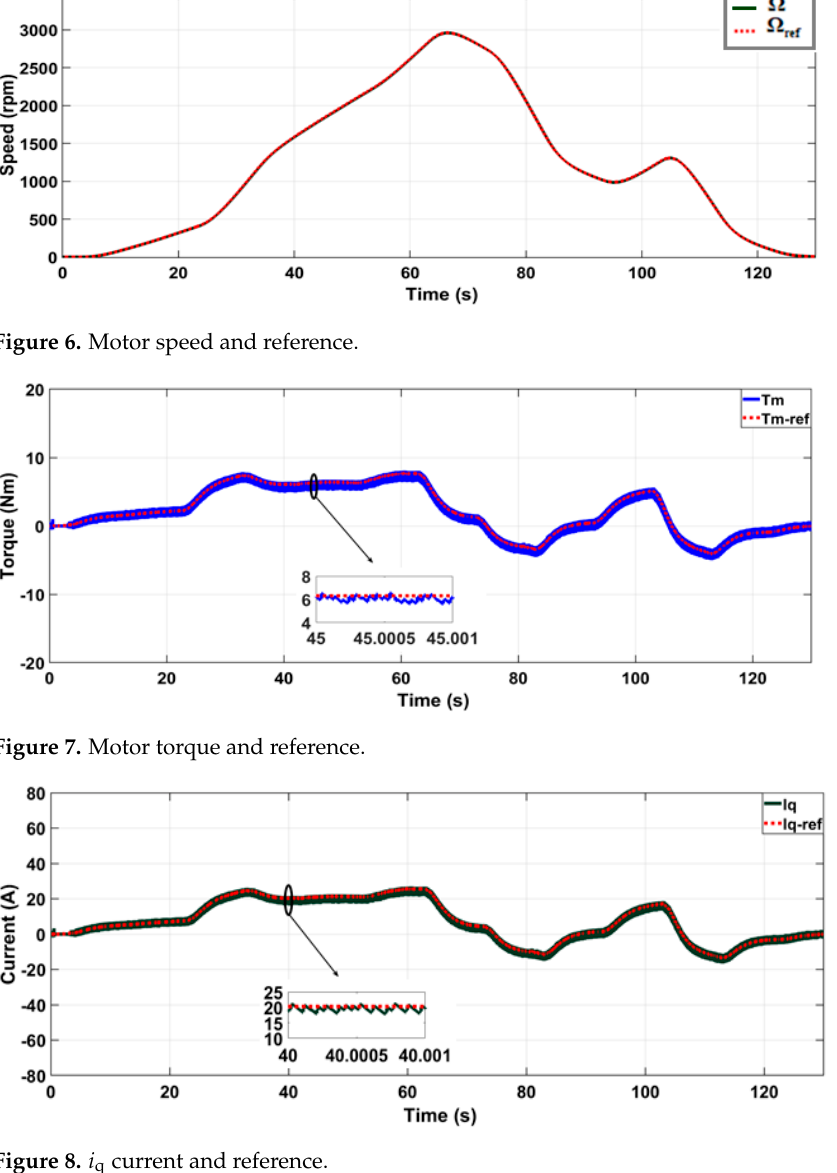
Figure 8. i q current and Figure 8. 𝑖 (cid:2927) current and reference.